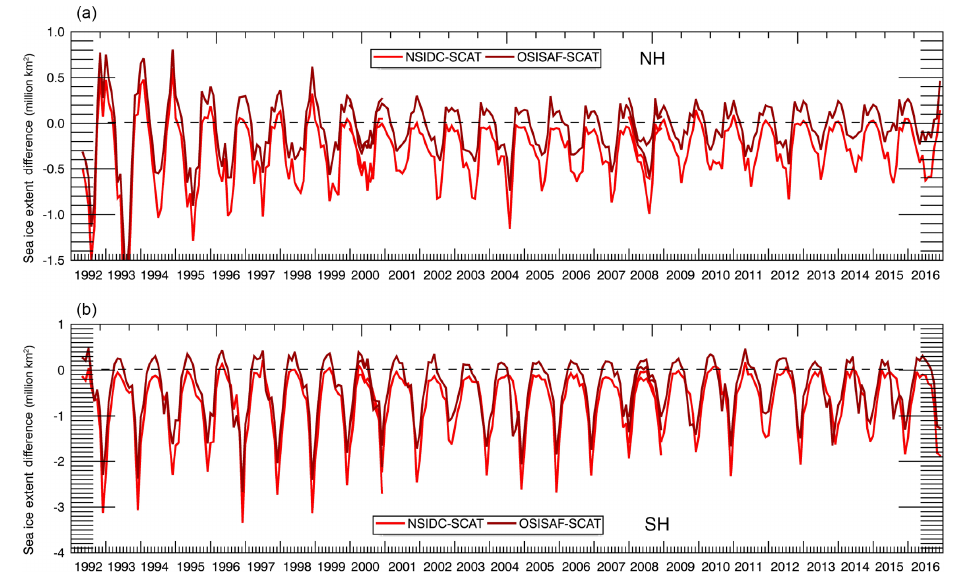
Figure 5. Time series of scatterometer sea ice extent differences to passive microwave (SSMI-based) products from NSIDC-0051 and OSI SAF-409a from 1992 to 2016 for the Arctic (a) and Antarctic (b)